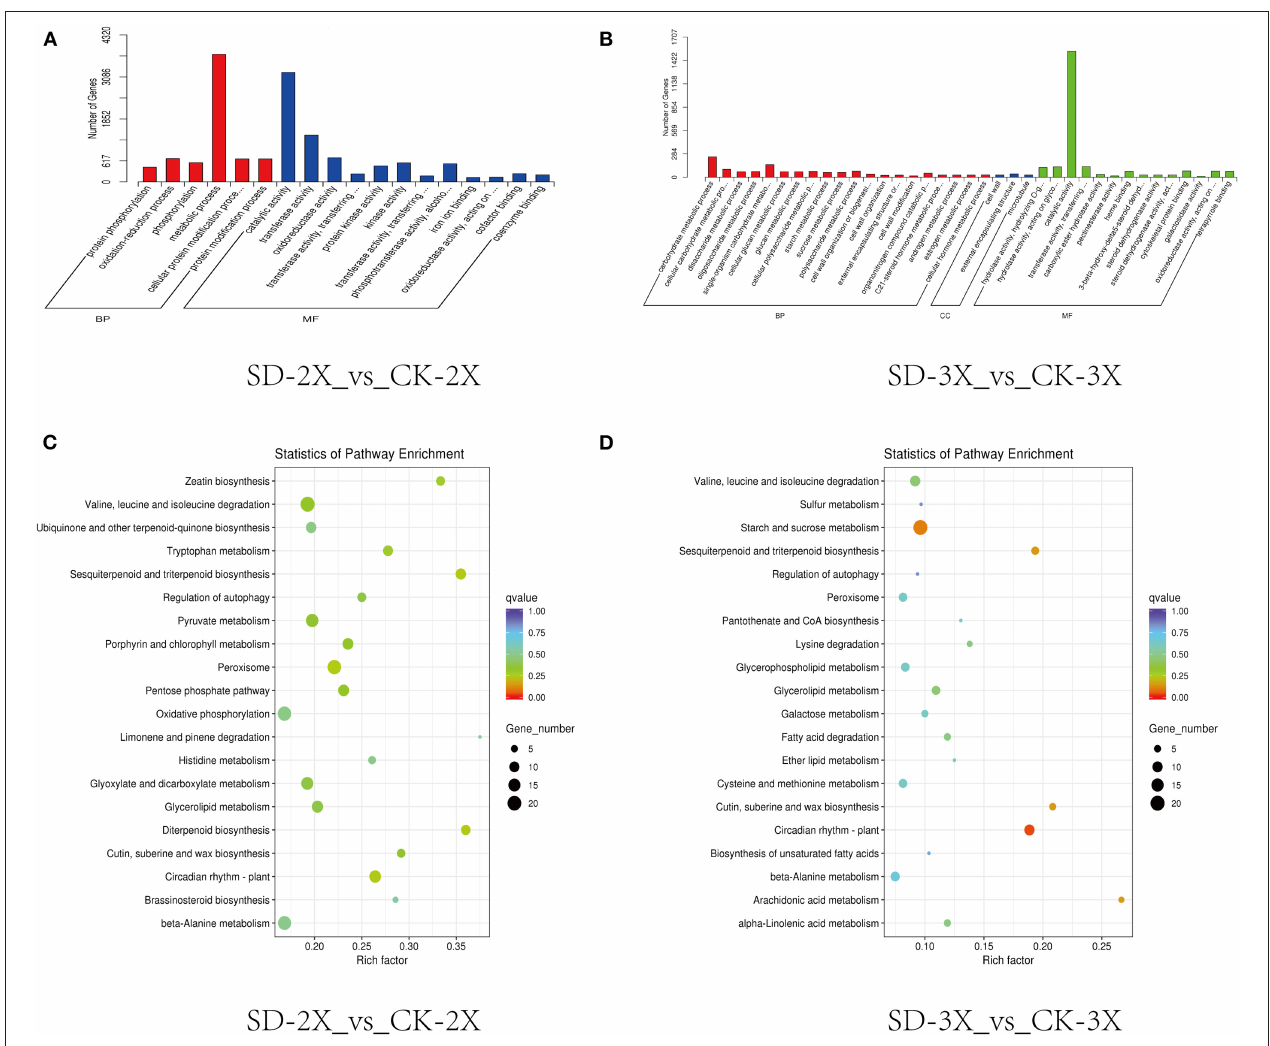
FIGURE 2 | Transcriptome analysis of diploid (2X) and triploid (3X) in response to drought stress. (A) GO classification analysis of DEGs in diploid (2X) response to drought stress. (B) GO classification analysis of DEGs in triploid (3X) in response to drought stress. (C) The top 20 enriched pathway in drought stress conditions in diploid (2X). (D) The top 20 enriched pathway in drought stress conditions in triploid (3X). The size and the color of solid circles represent the number of transcripts involved in certain pathways and the significant value (q-value) of the rich factor, respectively. CK, control; SD, severe